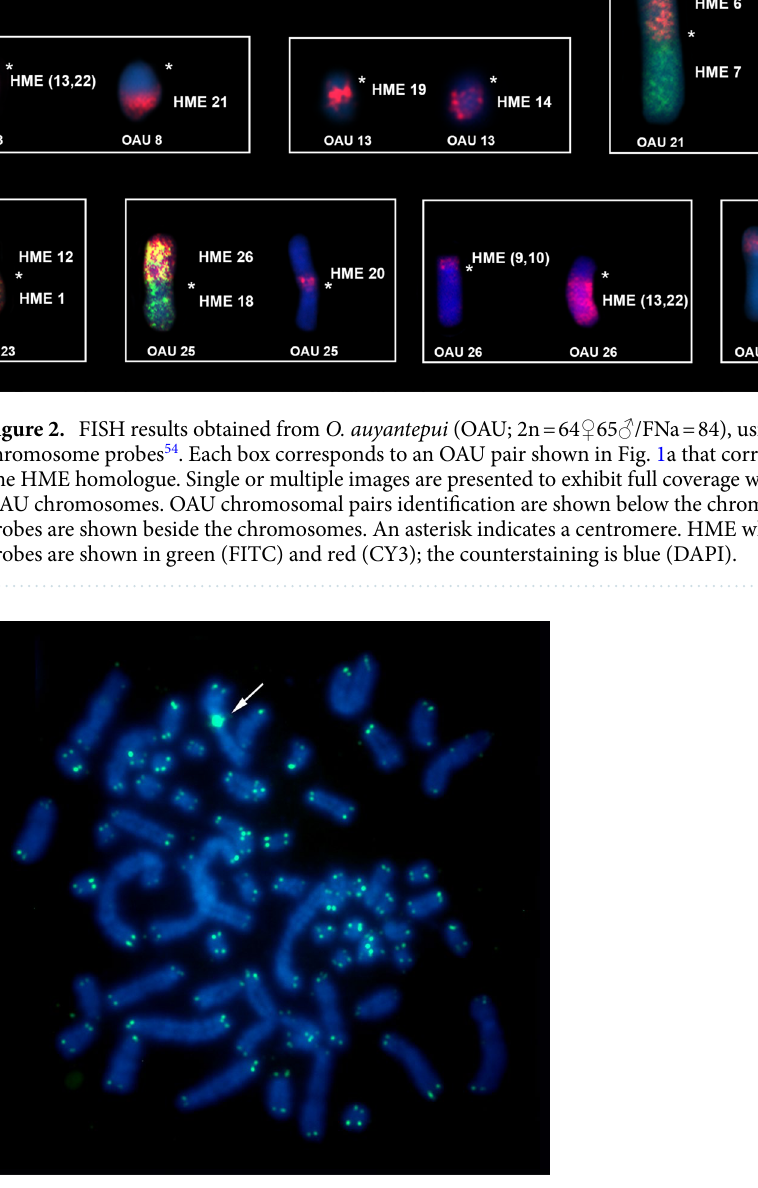
Figure 3. FISH results obtained from O. auyantepui (OAU; 2n = 65 ♂ /FNa = 84), using telomeric probes. Arrow indicates the interstitial telomeric sequence (ITS) at the Neo-X chromosome. Telomeric probes are shown in green (FITC); the counterstaining is blue